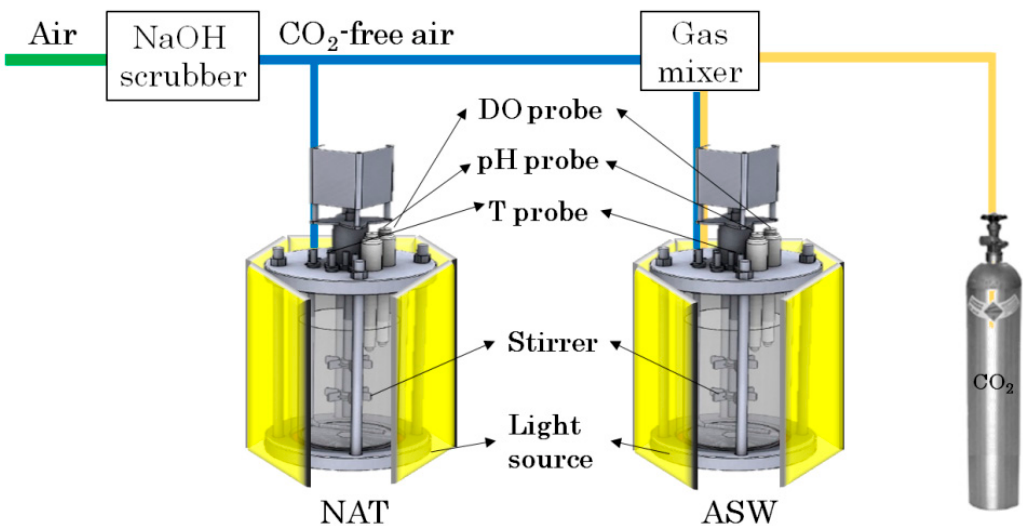
Figure1. Schematicdescriptionofphotobioreactorsusedforthethree T.rotula cultureexperiments. Figure 1. Schematic description of photobioreactors used for the three T. rotula culture experiments.